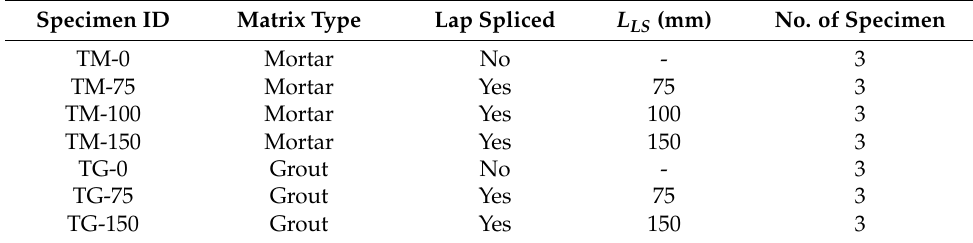
Table 4. Characteristics of tensile test specimens.